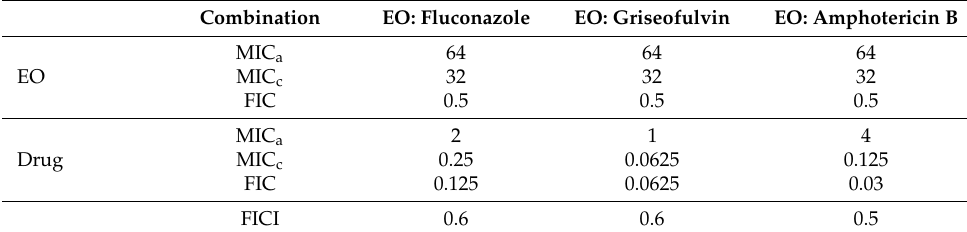
Table 4. Combined effects of Hypericum scabrum essential oil and conventional antimicrobial drugs on Trichophyton rubrum